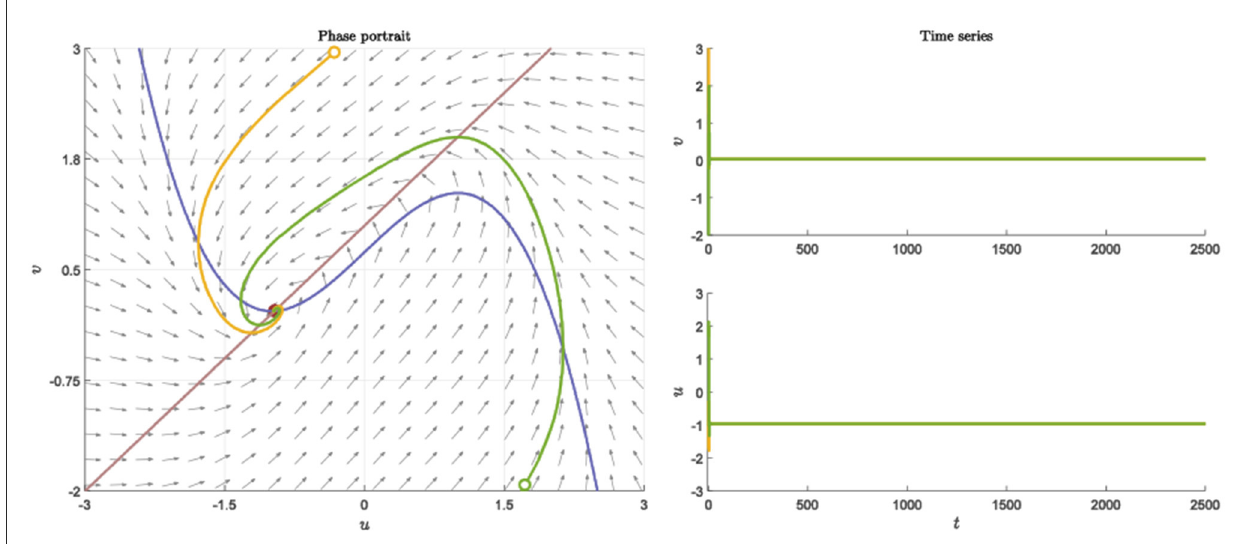
FIGURE1 Nullcline, phase portraits with different initial value and time series when a